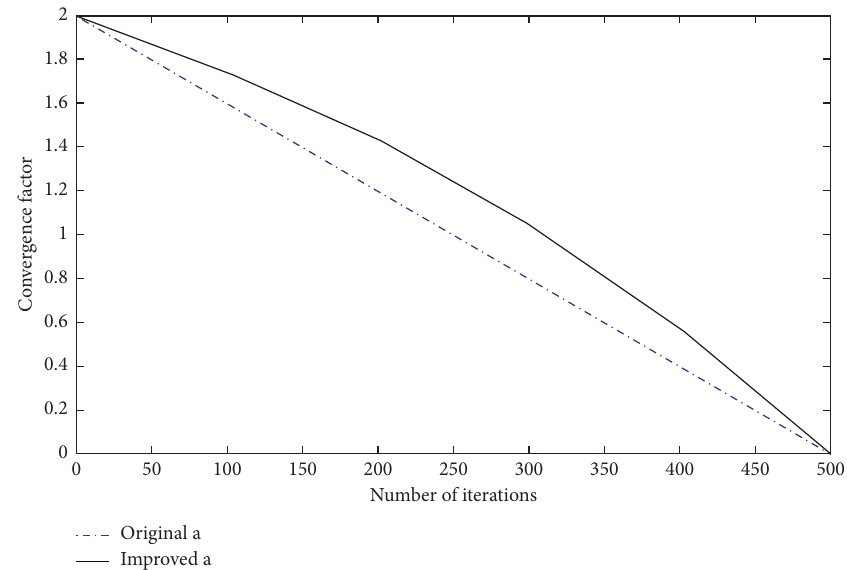
Figure 3: The change of the convergence factor.